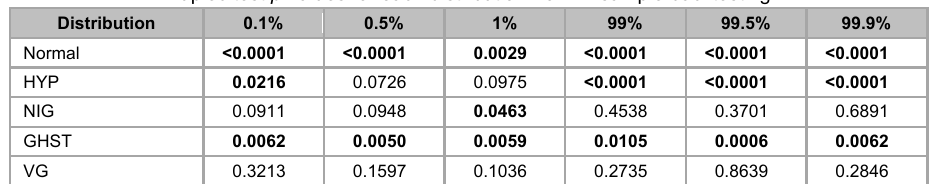
Kupiec test p -values for each distribution from in-sample backtesting Distribution